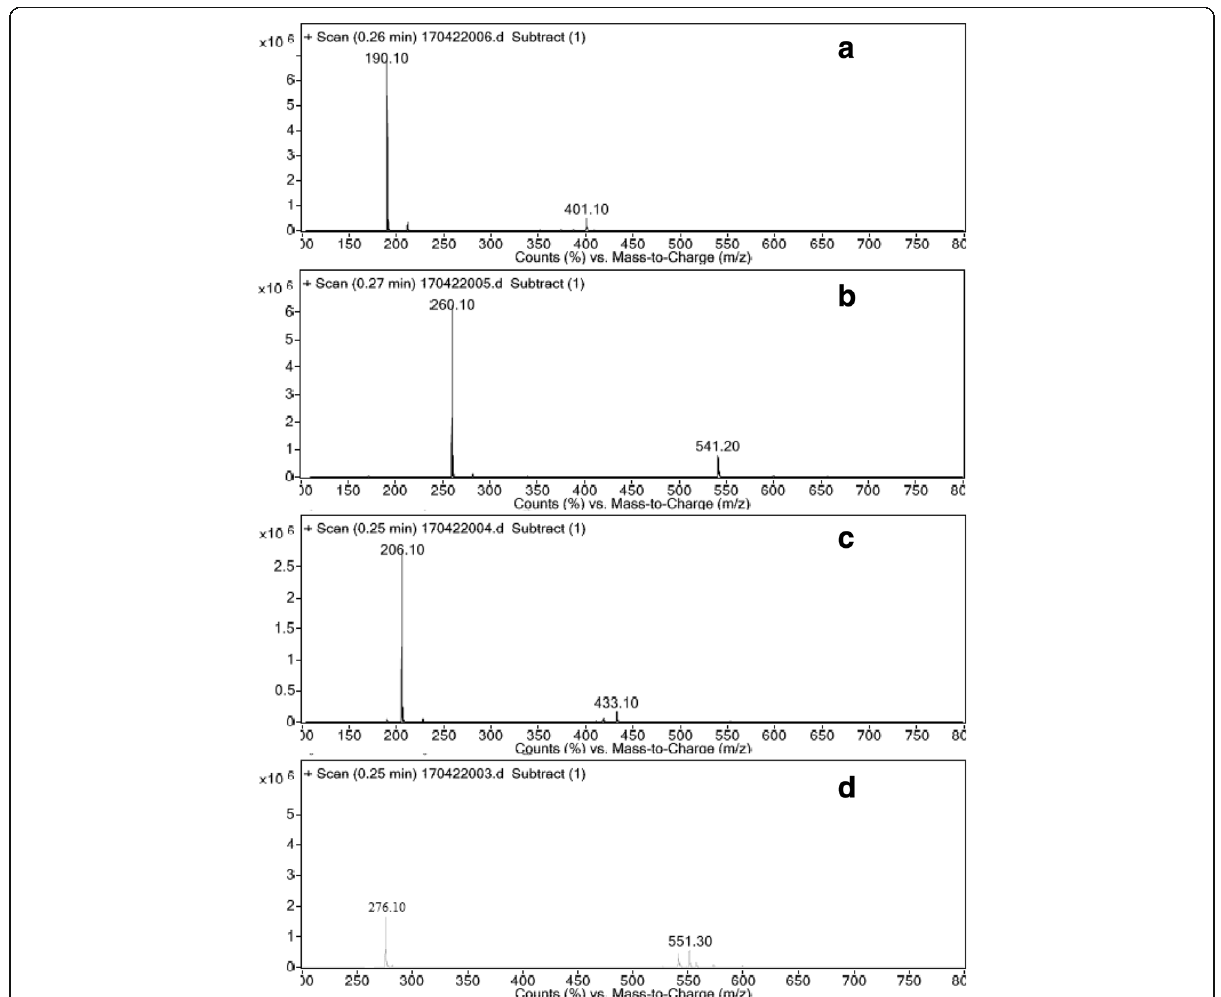
Fig. 7 Scan mode m/z of a celgosivir, b castanospermin, c n-oxide impurity of celgosivir, and d n-oxide impurity of